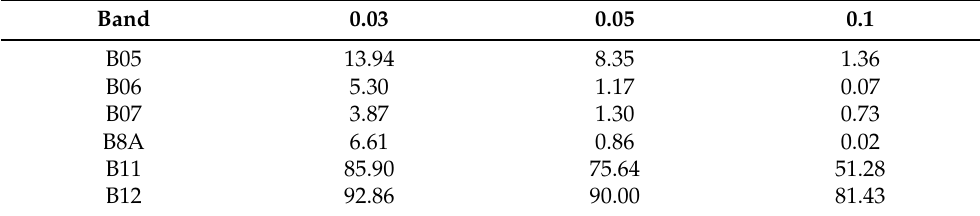
Table 12. Percentage of pixels beyond a given relative error threshold for reflectances in [0.75, 1] (L1C).